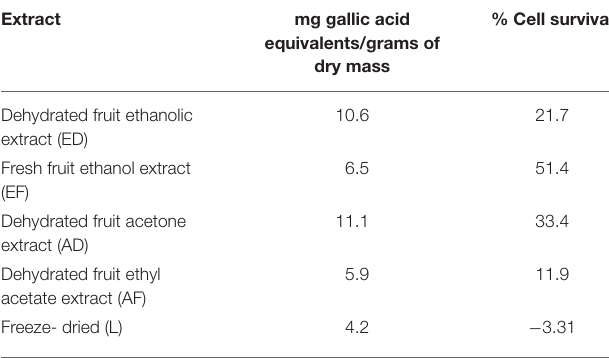
TABLE 1 | Quantification of phenols and relation of percentage of survival of T98g cells in relation with Rotenone control treatment. Extract mg gallic acid % Cell equivalents/grams of dry mass